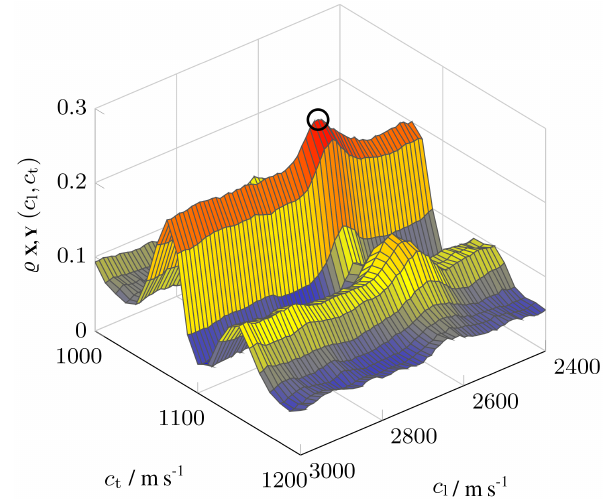
Figure 12. Result of the linear prediction method for dispersion analysis applied to data measured on a polymer plate (polyamide 6, thickness 8.8mm). Grey points are omitted.